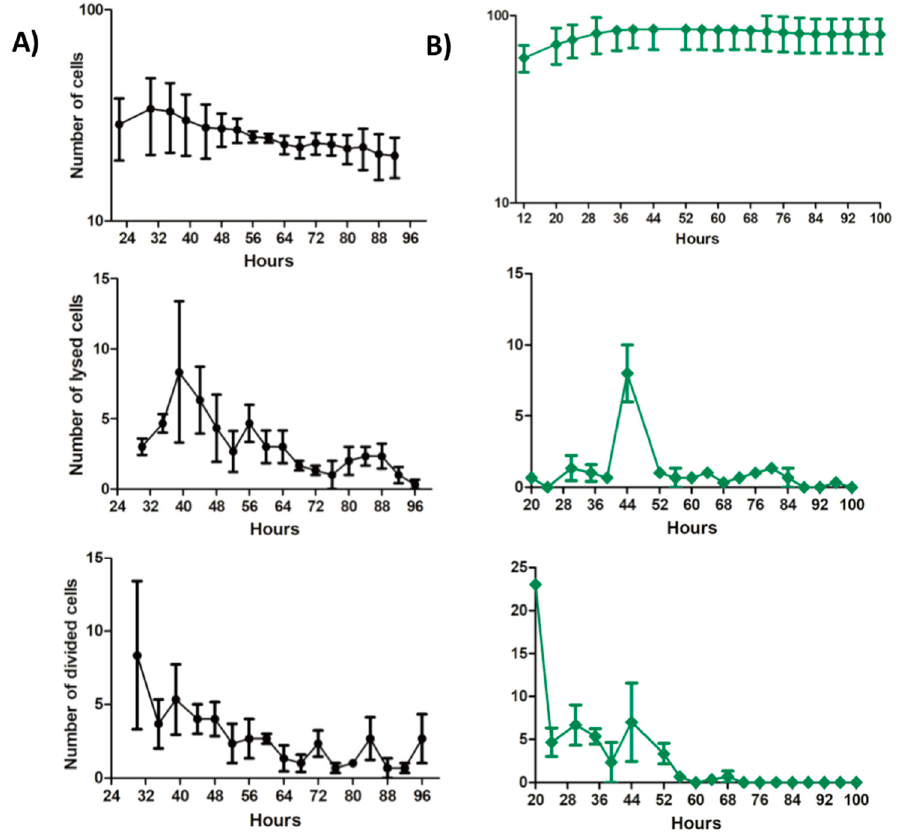
Figure 5. Quantitative single-cell analysis using on-chip-microscopy images of wild-type M. smegmatis ( A ) and the msm0031::Tn mutant ( B ) during 72 h of INH (50 µg/mL) exposure. The first panel illustrates the cumulative behaviour of the cells as a composite of lysis and division events. The second panel shows the number of cells that lysed during each successive time interval. The third panel presents the number of cells that divided in each successive time interval. The data present the mean and standard errors of three points in the microfluidic device.